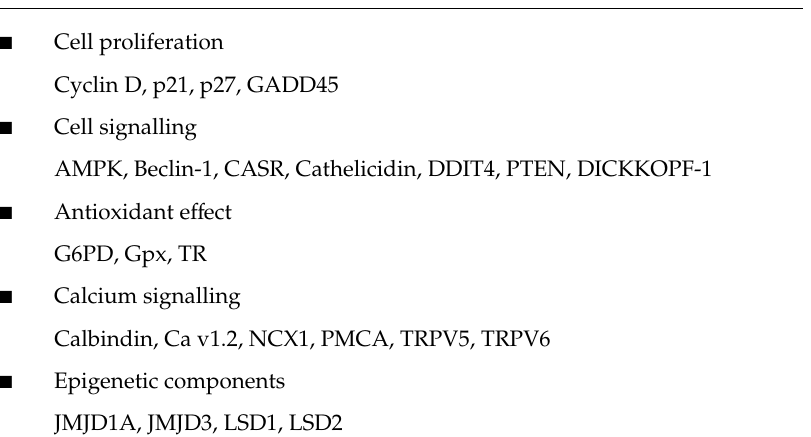
Table 1. Major signalling pathways activated by